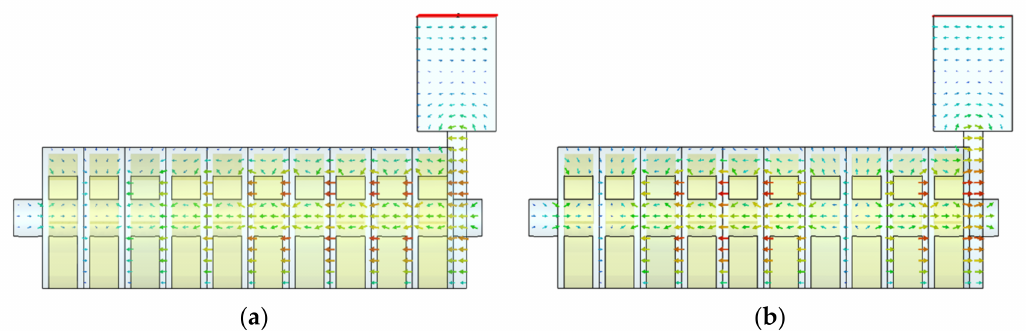
Figure 3. ( a ) E-field distribution of the TM 01 -(2 π − π /10) mode. ( b ) E-field distribution of the TM 01 -(2 π − 2 π /10) mode.